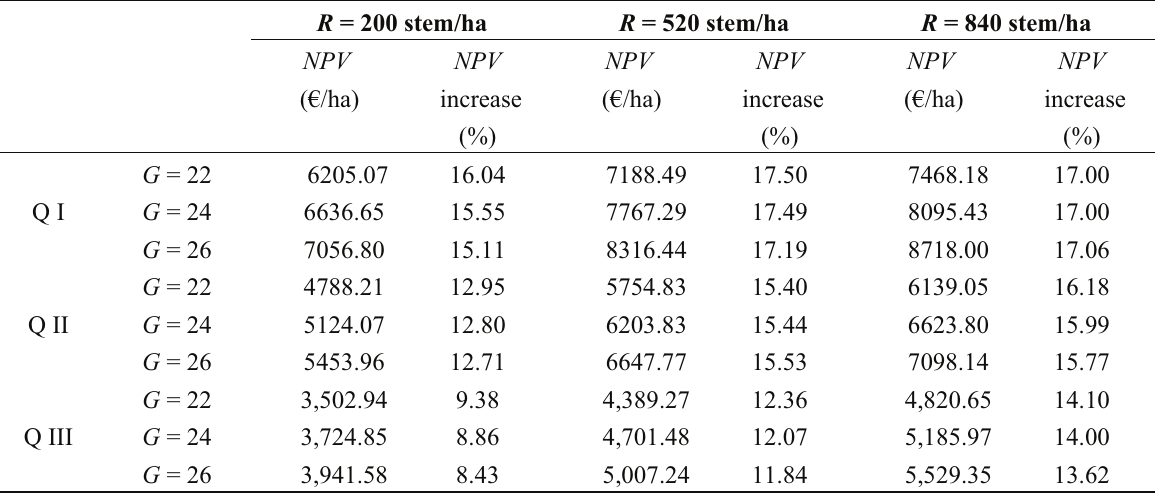
Table 5. *(cid:9)(cid:22)(cid:17)(cid:21)(cid:10)+,"(cid:4) -(cid:4) )(cid:12)(cid:20)(cid:19)(cid:9)"(cid:27)(cid:4) (cid:16)(cid:7)(cid:8)(cid:8)(cid:9)"’(cid:7)(cid:13)(cid:24)(cid:21)(cid:13)&(cid:4) (cid:10)(cid:7)(cid:4) (cid:10)(cid:11)(cid:9)(cid:4) (cid:24)(cid:21)"(cid:10)(cid:12)(cid:13)(cid:16)(cid:9)(cid:4) %(cid:9)(cid:10)#(cid:9)(cid:9)(cid:13)(cid:4) (cid:10)(cid:11)(cid:9)(cid:4) (cid:24)(cid:21)(cid:12)(cid:6)(cid:9)(cid:10)(cid:9)(cid:8)(cid:4) distribution associated with the optimal harvesting strategy (for t = 70 years) and the stable diameter distribution ( W ), as well as population growth rates, (cid:2) 0 cycle (from t = 0 to t = 70 years) ( G in m 2